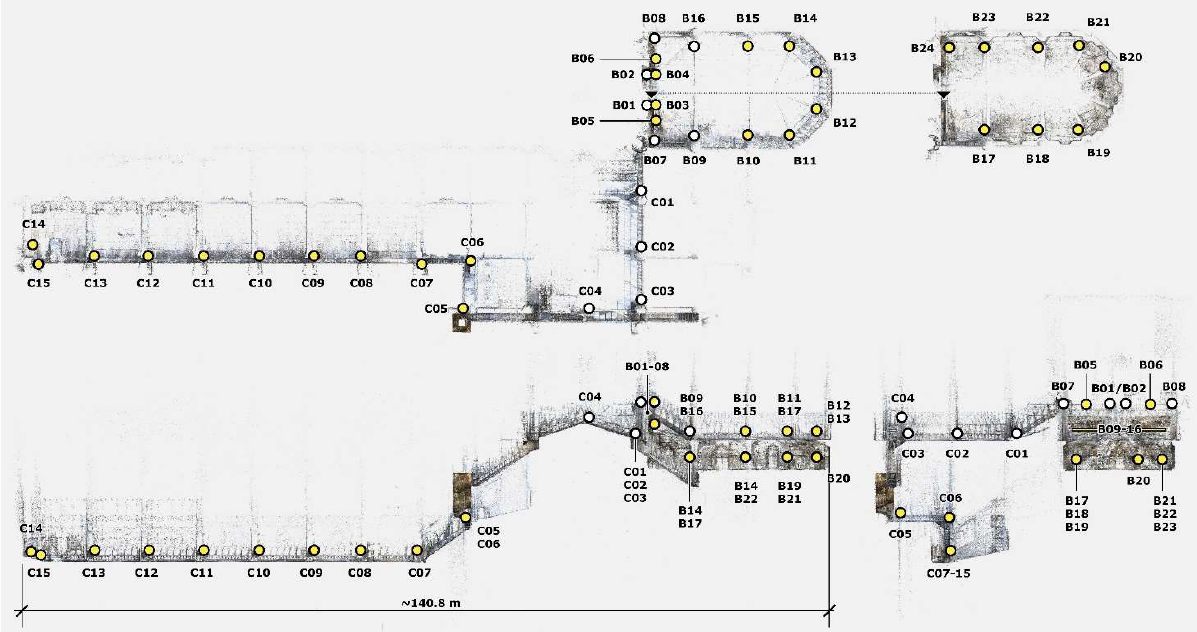
Figure 7. Point cloud result of Path B and Path C. Top views (top) and elevation views (bottom): front elevation bottom left and side elevation bottom right. According to Table 3 “Path B” and “Path C”, points in white are used as GCPs in the “max drift check”.